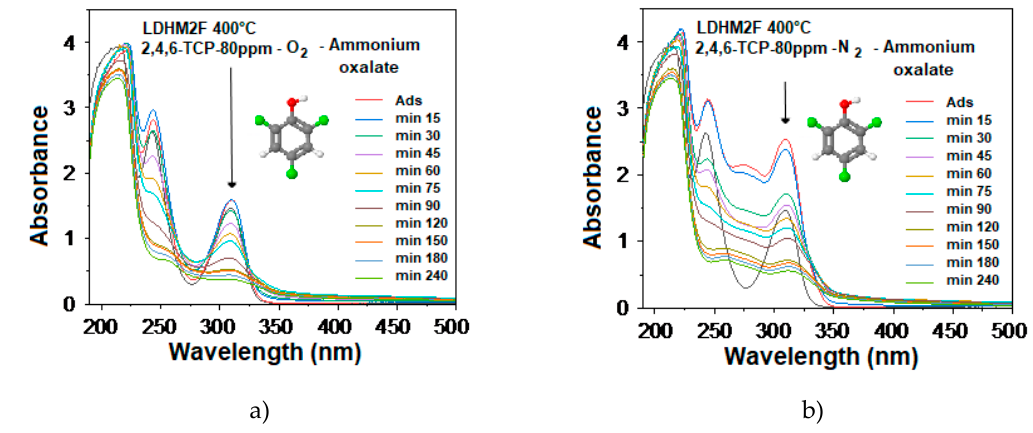
Figure 15. Absorption of UV-Vis for the photodegradation of 2,4,6-trichlorophenol in the presence of ammonium oxalate as a hole capture agent: ( a ) in the presence of oxygen; ( b ) in the presence of nitrogen.